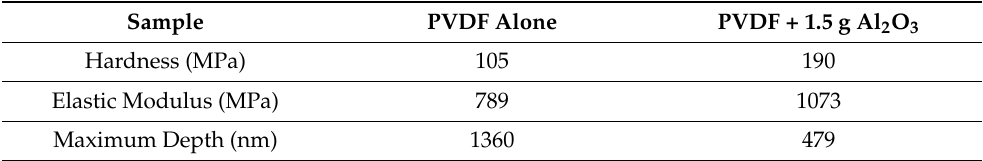
Table 4. Hardness and elastic modulus values for coatings of both PVDF alone and PVDF + 1.5 g